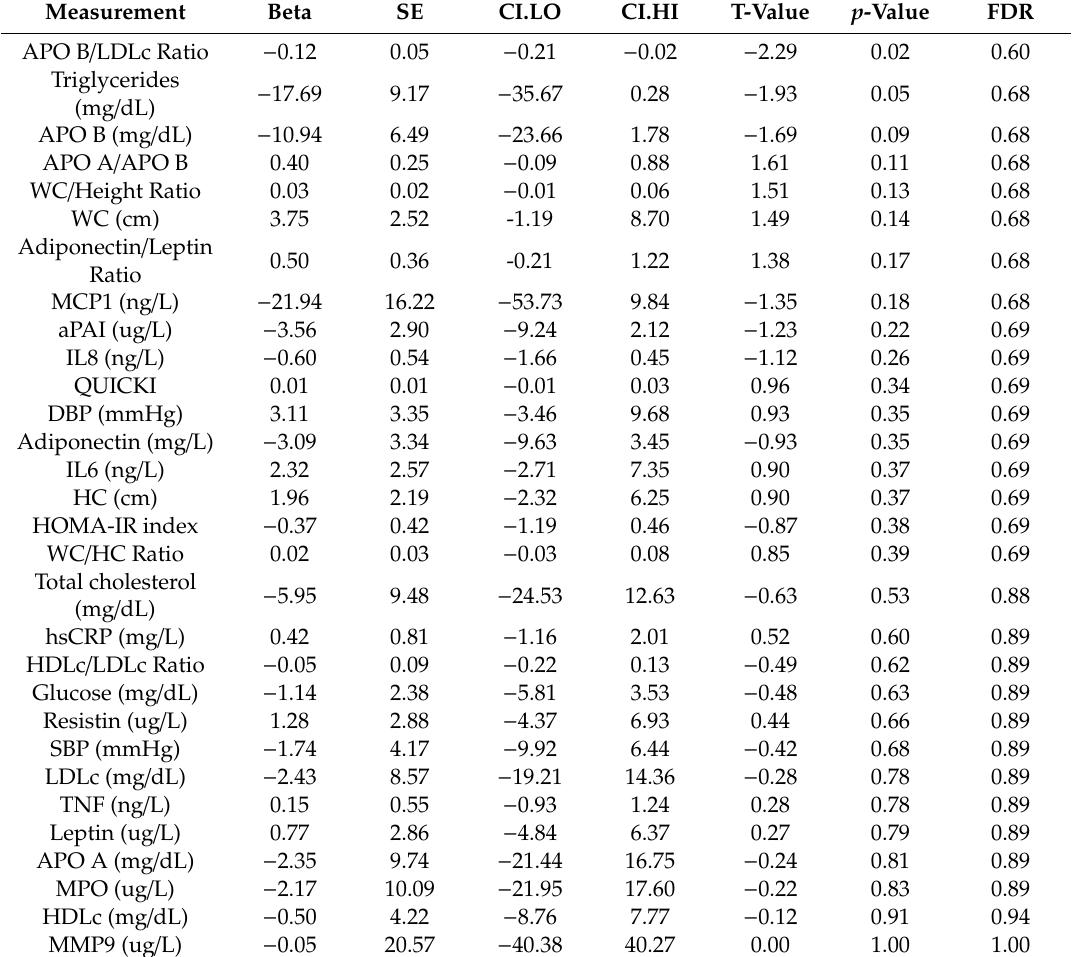
Table 2. Association between the pGRS and metabolic outcomes in the cross-sectional cohort of 574 children (study population 1), in decreasing order of statistical